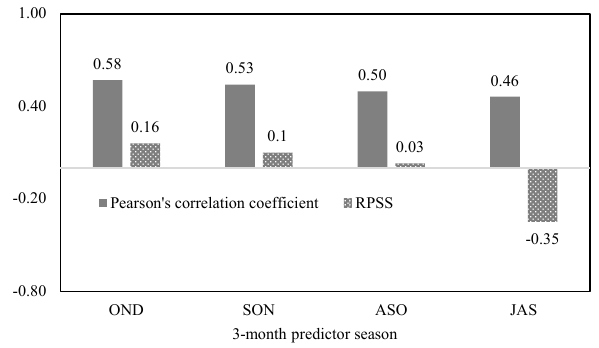
Figure 12. Correlation coefficients between observed and modeled JFM precipitation and ensemble RPSS for various lead